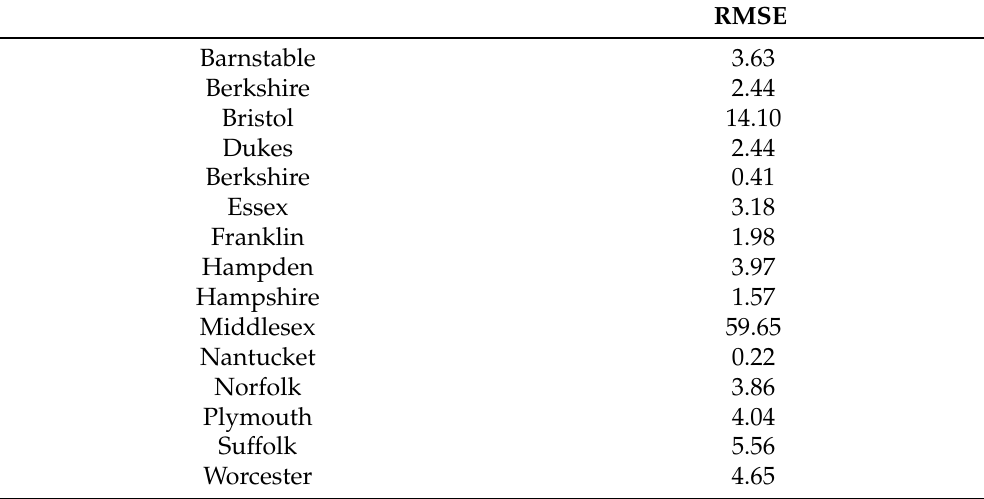
Table A3. Performance of the Proposed Prophet BU model for each county in MA.